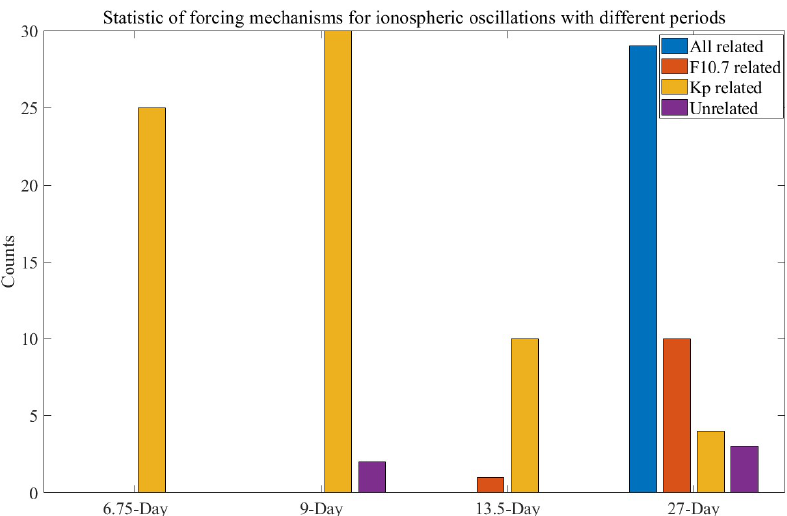
Figure 7. Four types of relationships between the different ionospheric oscillations with solar activity and geomagnetic activity.